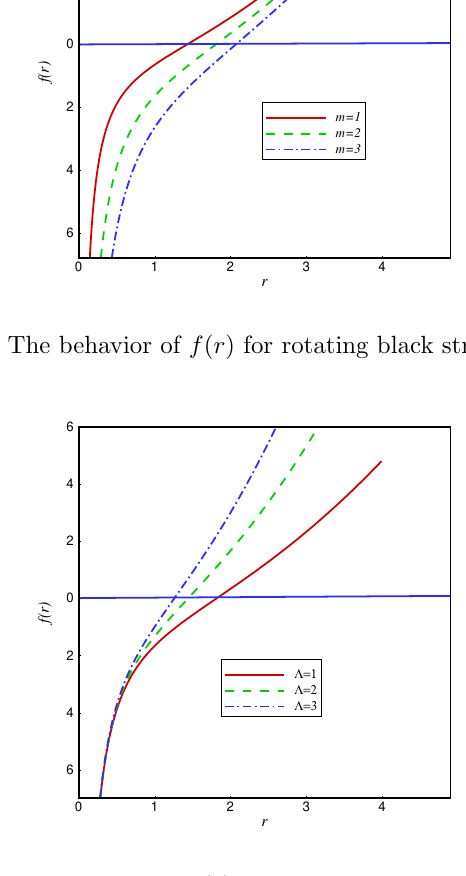
Figure 2 . The behavior of f ( r ) for rotating black string with m =